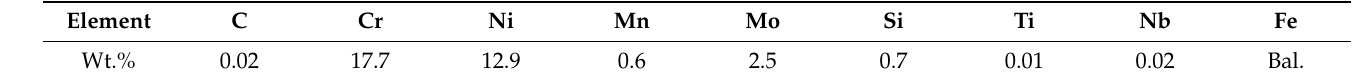
Table 1. The chemical composition of the printed 316L stainless steel. Element C Cr Ni